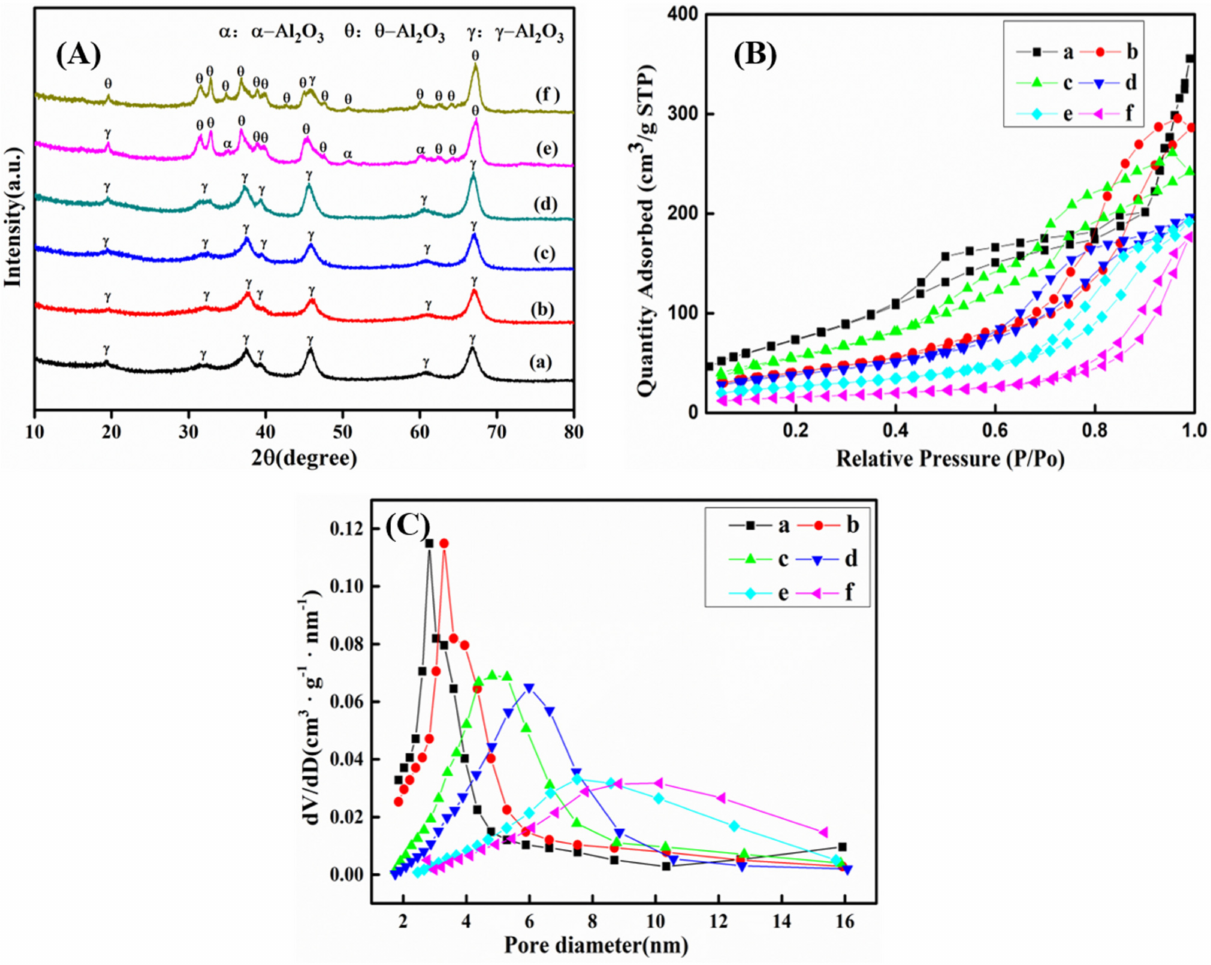
Figure 2. XRD pattern ( A ), nitrogen adsorption-desorption isotherms ( B ), and pore-size distribution curves ( C ) of the precipitate heat treated at various temperatures: (a) 500 ◦ C; (b) 600 ◦ C; (c) 700 ◦ C; (d) 800 ◦ C; (e) 900 ◦ C; (f) 1000 ◦